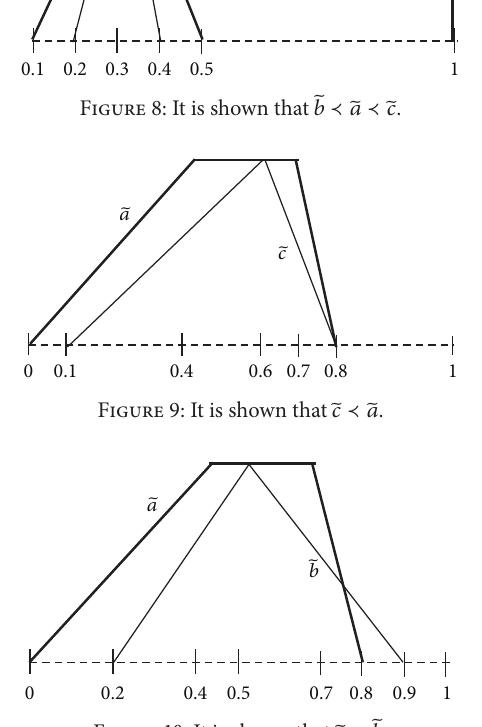
Figure 10: It is shown that ̃𝑎 ≺